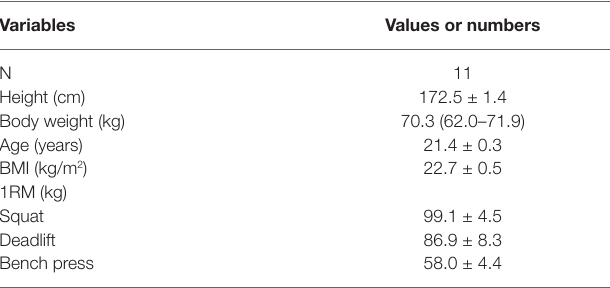
TABLE 1 | Physical characteristics of the subjects.